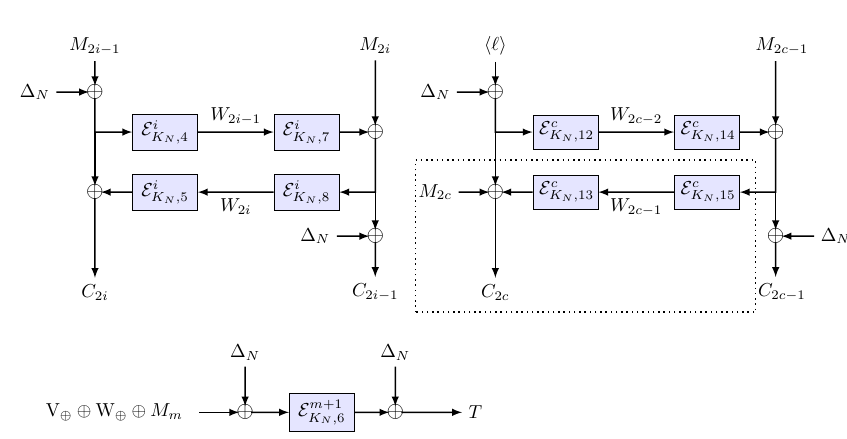
Figure 2: Processing of an m block message M and Tag Generation (assuming an odd number of input blocks) for LOTUS . The upper left part shows the message processing of an intermediate di-block and the upper right part depicts the message processing of the final di-block. The lower part shows the tag generation process. c denotes the number of di-blocks in the message i.e. c = d m/ 2 e − 1. The dotted part in the final di-block is executed only when the message has even number of blocks. We use the notation e E i denote invocation of e E with key α a + i (cid:12) K N and tweak j , where a denotes the number of blocks of associated data corresponding to the message. Here W ⊕ denotes the intermediate checksum value and V ⊕ denotes the AD checksum value. h len i n is used to denote the n bit representation of the size of the final di-block in bits.